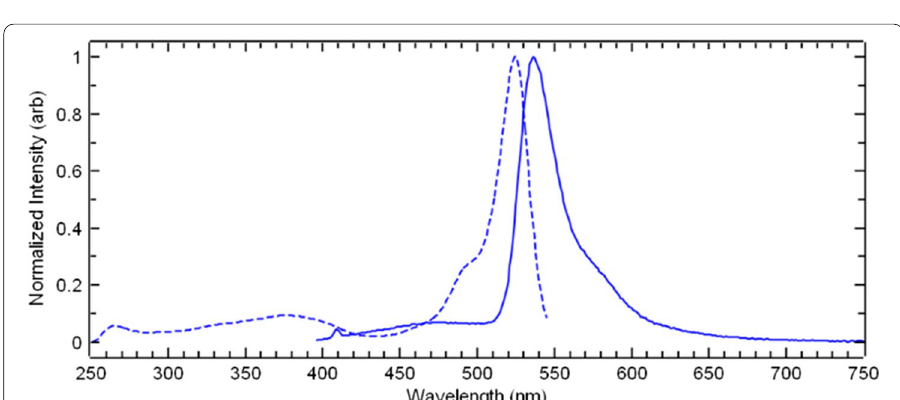
Fig. 1 Excitation (dashed) and emission (solid) spectra for DO3A-BODIPY-Tz ( 13 ) in DMSO with Φ fl , (0.38), excitation